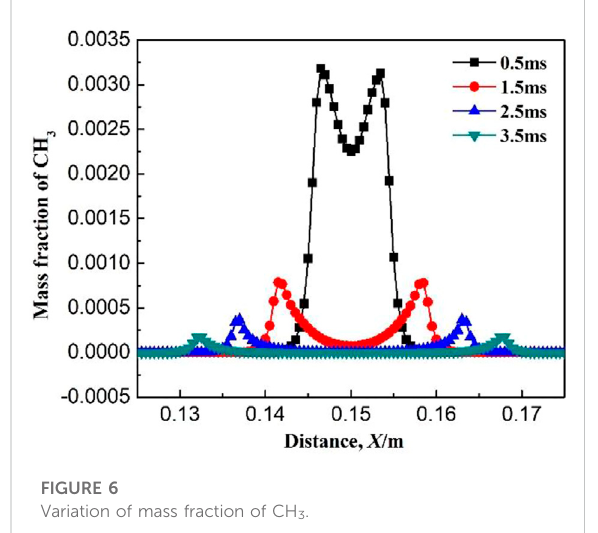
FIGURE 8 Variation of mass fraction of CH.